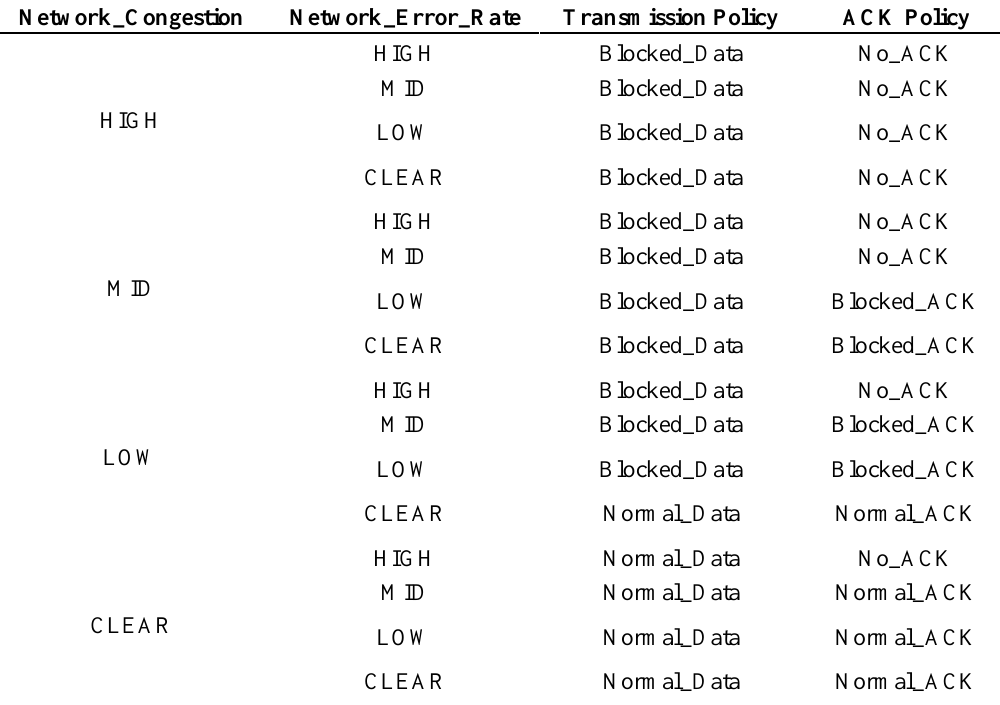
Table 3. Sample of